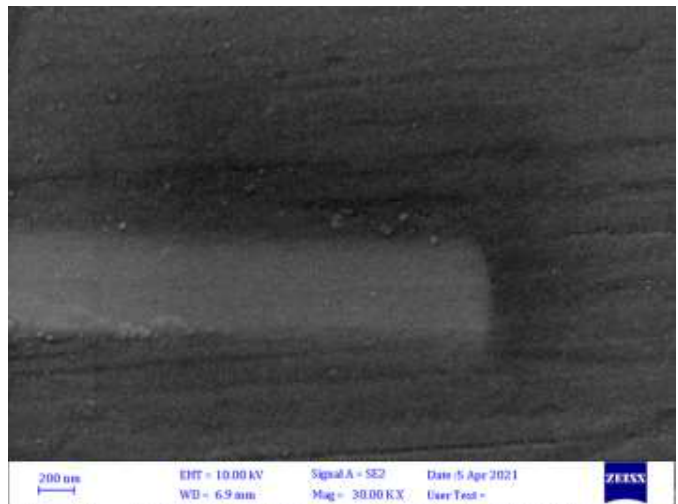
Figure 5: SEM images for the polished surface.